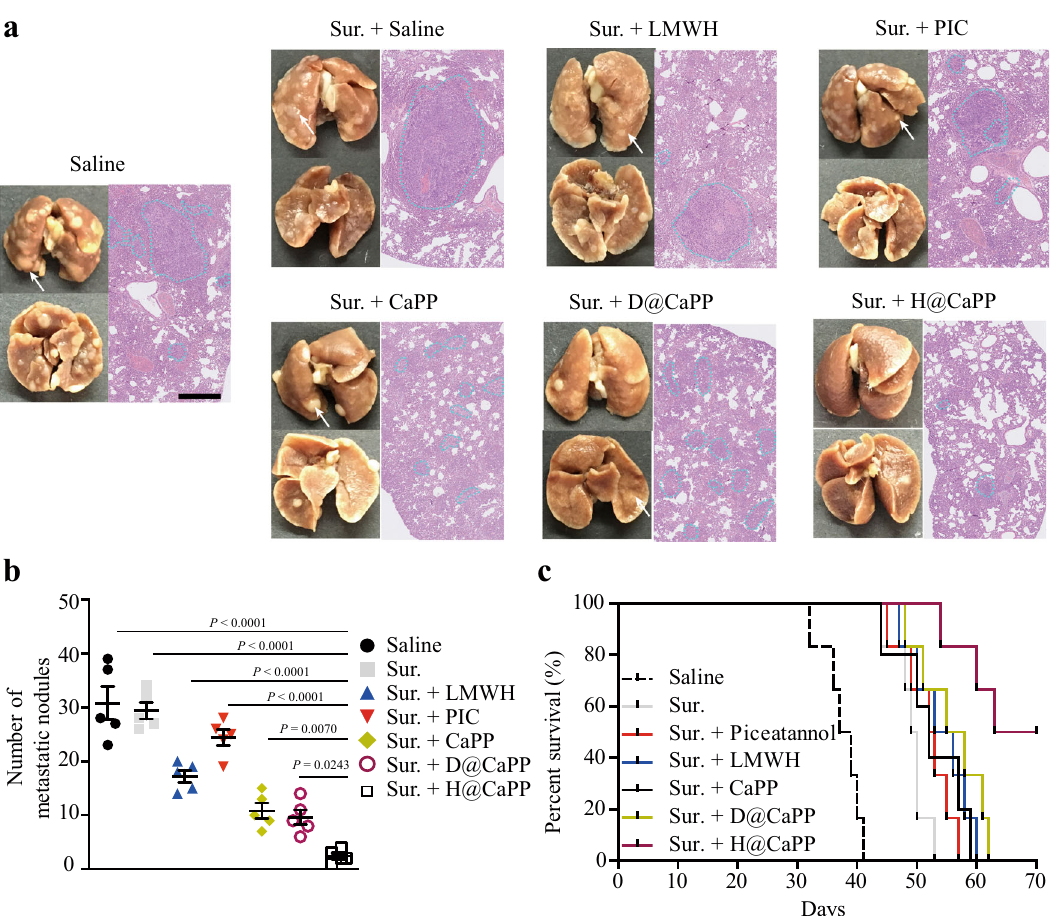
Fig. 10 H@CaPP combined with surgery resection achieved the anti-metastasis therapeutic effect in orthotropic primary tumor-bearing mice. a Typical lung tissues with visualized metastatic nodules (white arrows) from each group, and representative fi elds of lung tissues with metastasis areas (blue dotted lines) from each group with H&E. Black scale bar, 5 mm; Scale bar, 0.5 mm. b The number of metastatic nodules of the mice combined with surgical resection after intravenously administration with saline (without surgical resection), saline, LMWH, PIC, CaPP, D@CaPP or H@CaPP (i.v. at a dose of piceatannol or PP at 0.020 mmol/kg, at a dose of Dextran or LMWH at 10 mg/kg) for seven times during 14 days (ANOVA, mean ± SD, n = 5 mice per group). c Survival curve of orthotropic breast tumor-bearing mice combined surgery after intravenous administration with saline (without surgical resection), saline, LMWH, piceatannol, CaPP, D@CaPP or H@CaPP for seven times during 14 days ( n = 6 mice per group). Error bars represent